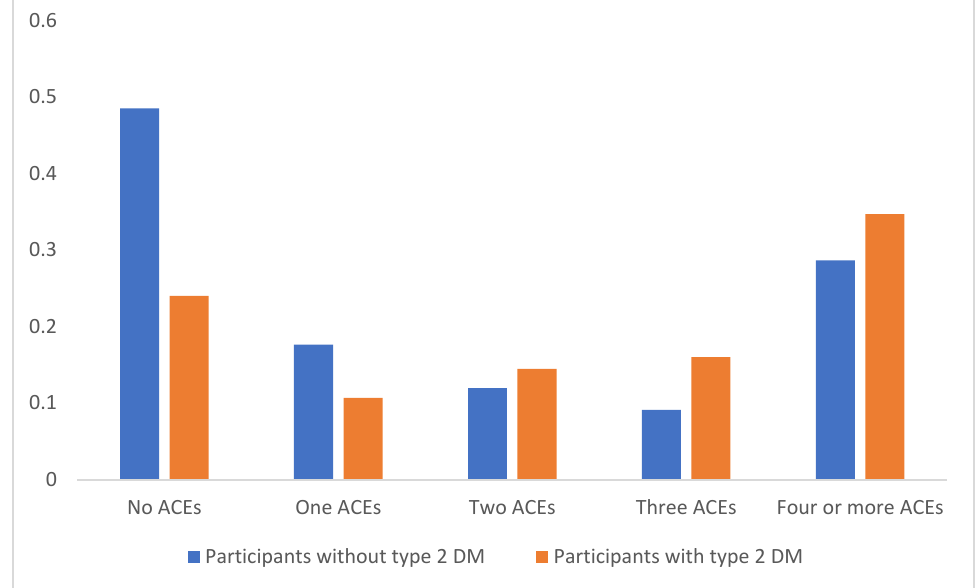
Figure 1. Association between ACEs and T2DM.